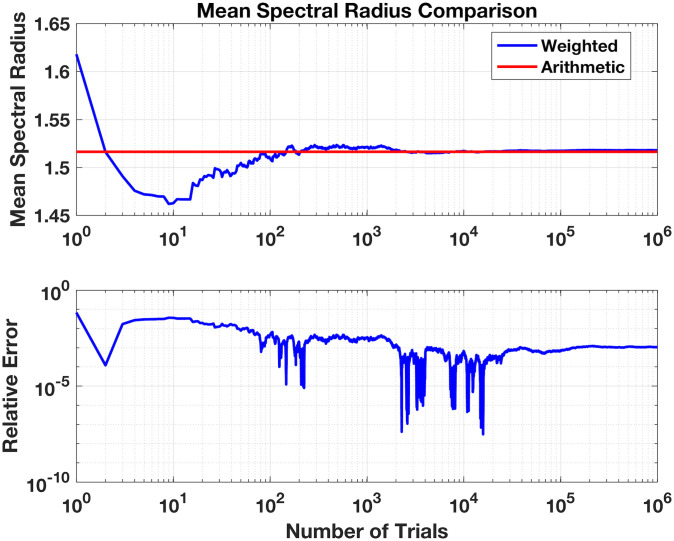
Comparison arithmetic average spectral radius over all five possible realisations for bi-degree sequence k = [1 2 1] and sampled mean spectral radius with weights via permutation method (see text).